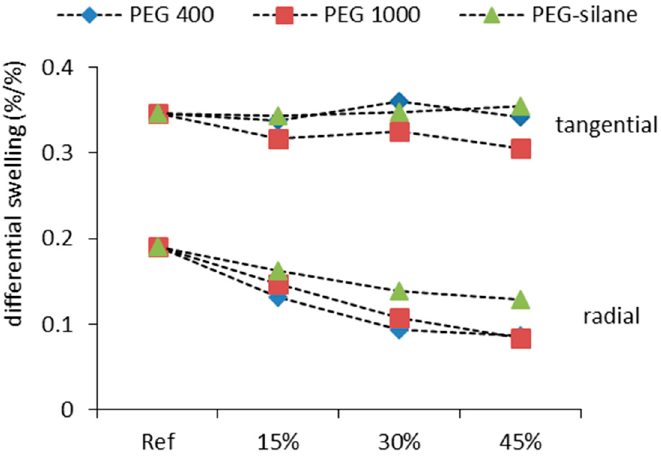
Figure 7. Differential swelling (percentage swelling per percentage change in moisture content) for differently treated oak wood specimens in radial and tangential anatomical directions (standard deviation of approx. 0.01 for radial and 0.02–0.03 for tangential direction not shown for better readability).